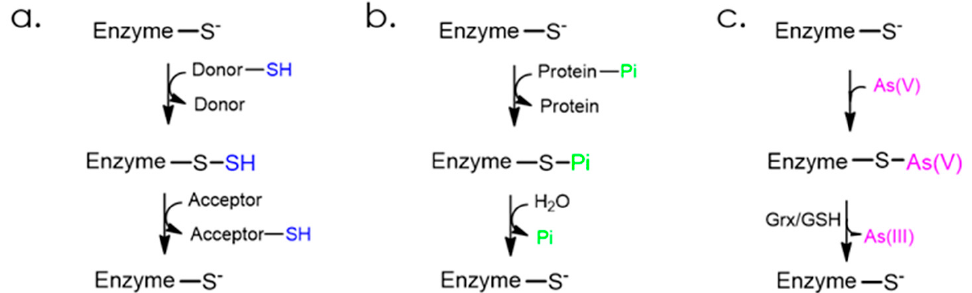
Figure 2. Two-step mechanisms for the reactions catalyzed by ( a ) sulfurtransferases, ( b ) phosphatases, and ( c ) arsenate reductases.